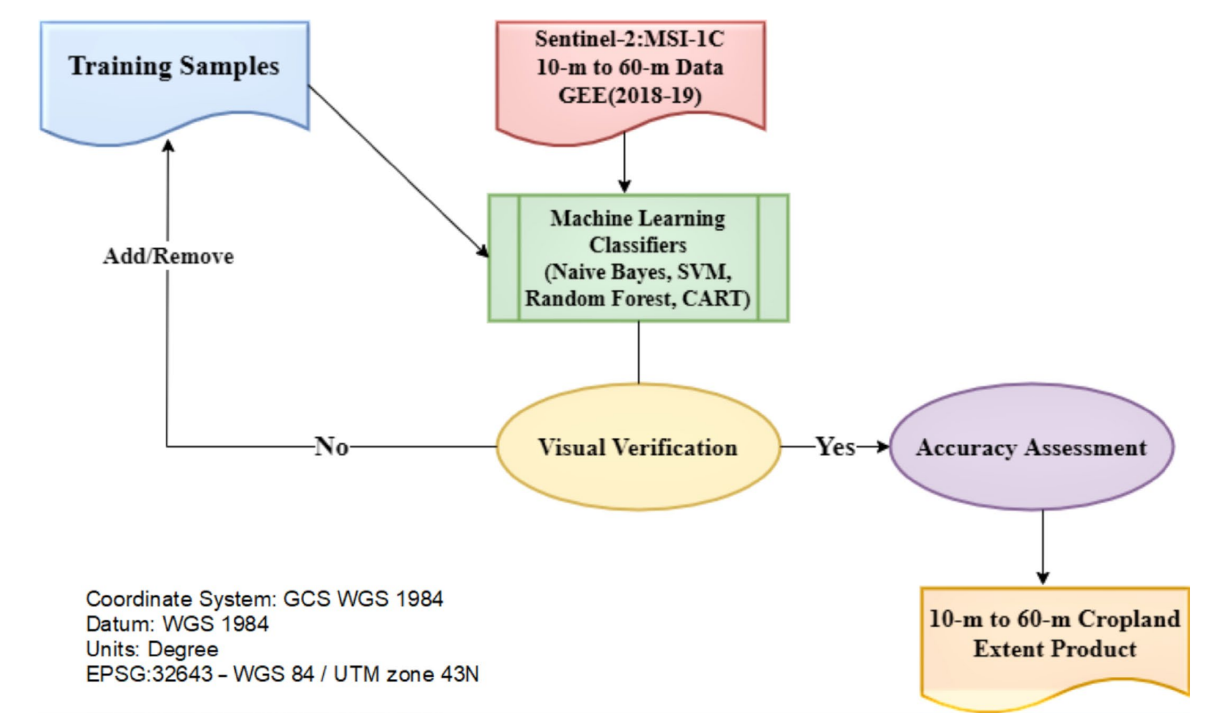
Figure 4. A review of cropland planning techniques. The research used classification algorithms for pixel-based supervised machine learning. The study was carried out on the cloud infrastructure framework of Google Earth